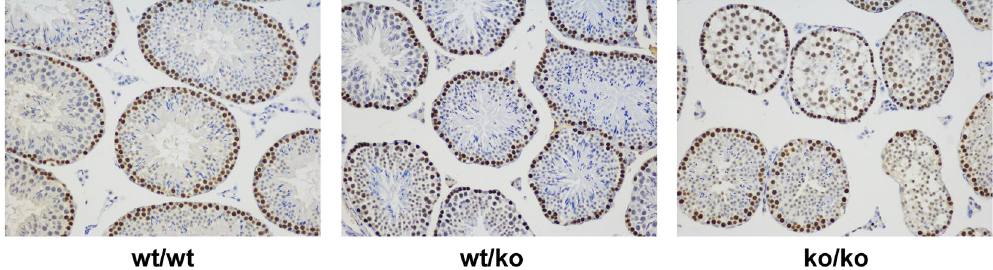
Figure 4. PCNA IHC of the testes of the three murine genotypes. From the left to the right is the testis of wild- type, heterozygous and GGNBP2 KO mice. 10 × 40, LM.